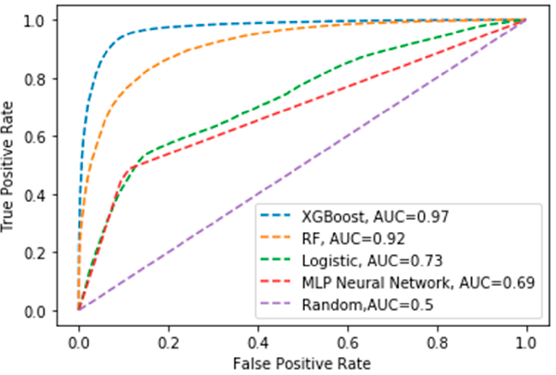
Optimized prediction scores of the different models. The hyperparameters tested for each model the balanced data (0.94 versus 0.97 when regional fire history is included, or 0.92 versus are presented, alongside the chosen values. 0.94 otherwise).